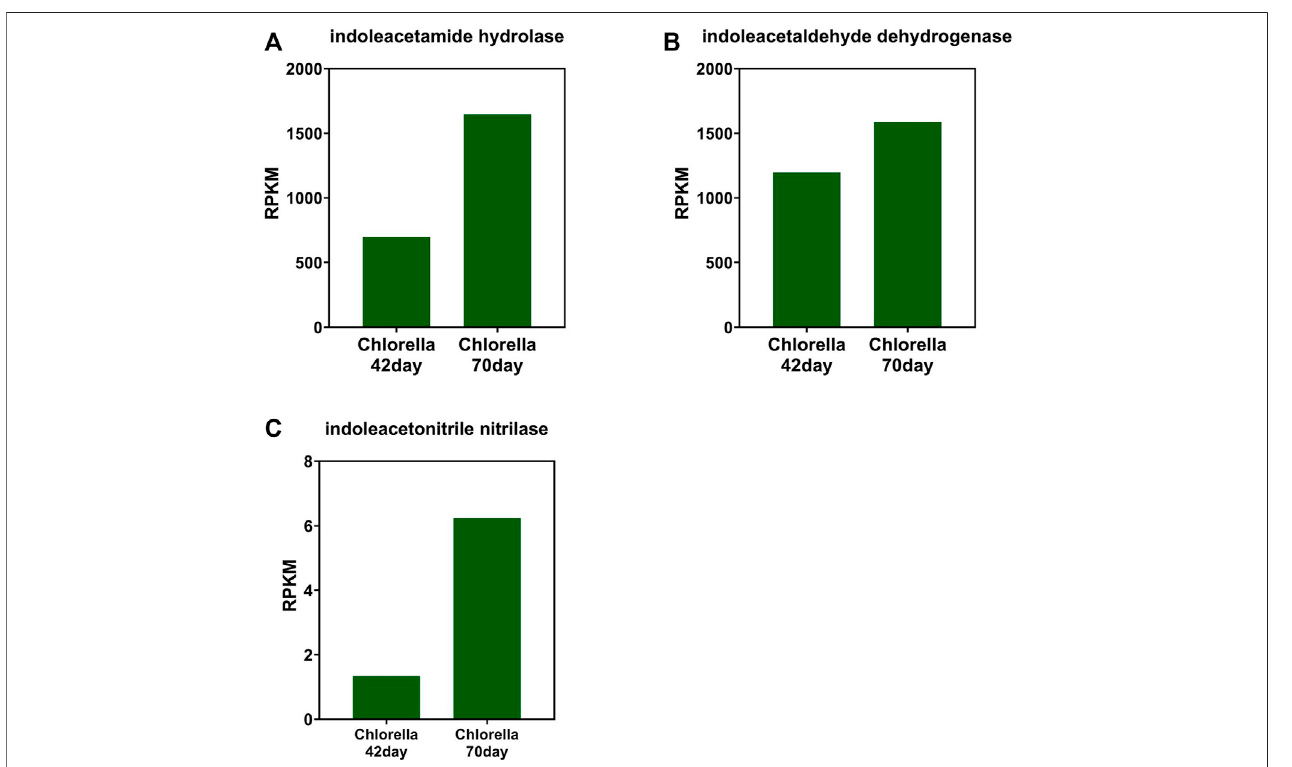
FIGURE 3 | Gene abundance of bacterial IAA synthetase in the Chlorella reactor. (A) Indoleacetamide hydrolase, (B) indoleacetaldehyde dehydrogenase, and (C) indoleacetonitrile nitrilase.